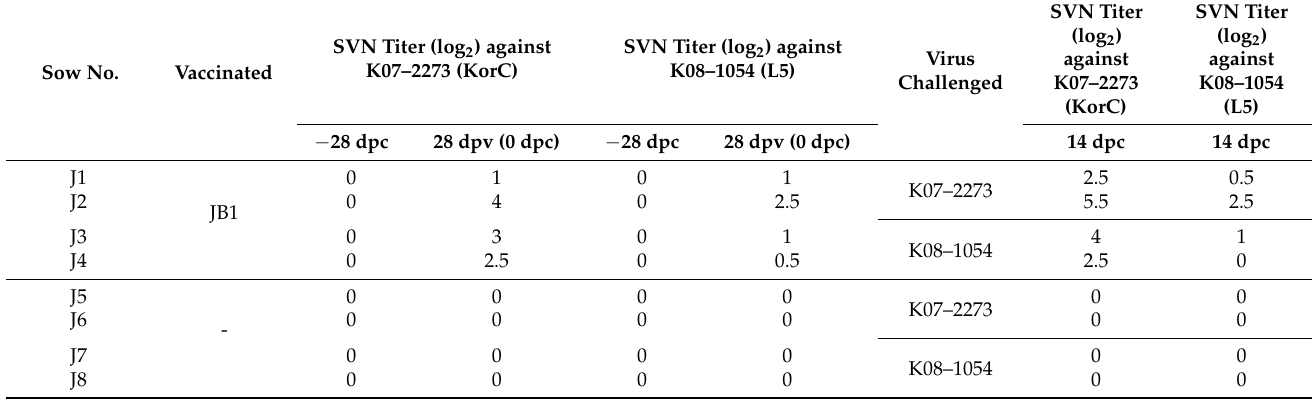
Table 2. Measurement of serum virus-neutralizing antibody levels after vaccination and virus challenge.